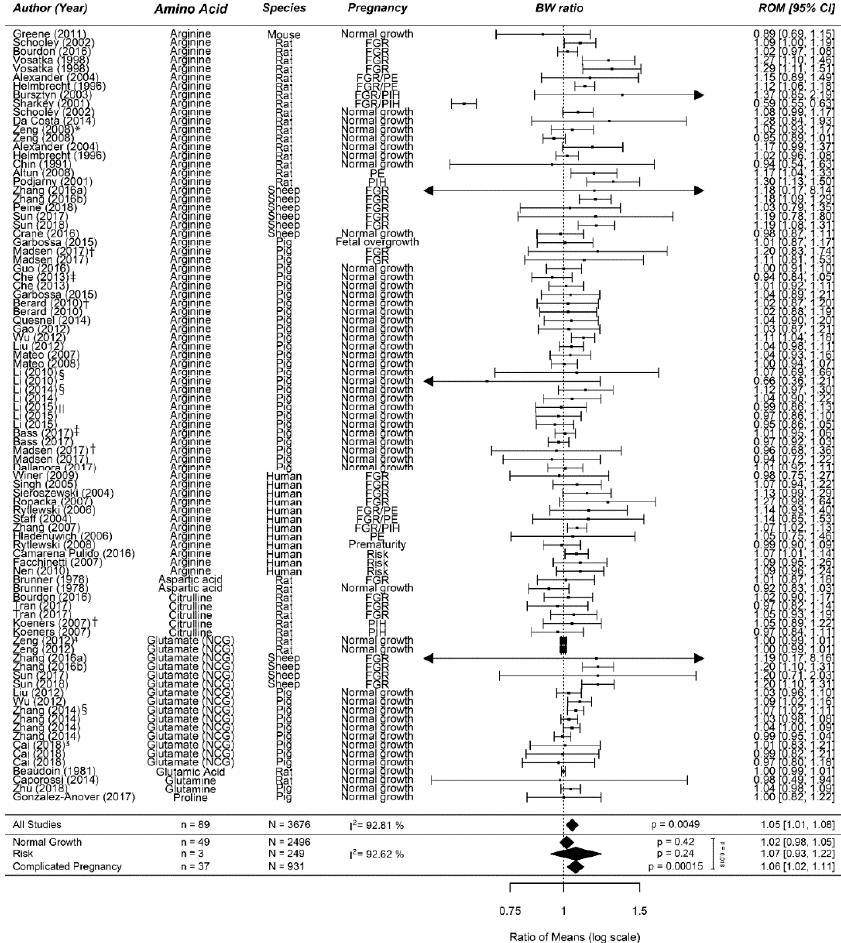
Figure 1. Meta-analysis on prenatal supplementation of amino acids from the arginine family on fetal / birth weight (BW): While there was no e ff ect of prenatal supplementation of amino acids from the arginine family in normal-growth pregnancies, it increased the birth weight ratio in a risk population and in complicated pregnancies. The data is ordered within each amino acid from smallest to largest animal. Data represent pooled estimates expressed as a ratio of means (ROM) with a 95% confidence interval (CI) using a random e ff ect model. Residual I 2 is shown. Some studies had multiple cohorts and are distinguishable in this figure by the following: * supplementation during full pregnancy in this upper line compared to partial in the next line; † this upper line is female o ff spring compared to the next line which is male o ff spring; ‡ in this upper line, the supplementation period was shorter compared to the next line(s); § in this upper line, the daily dose is lower compared to the next line(s); || in this upper line, primigravid animals were used compared to the next two lines of multigravida animals; and in the last two lines, the dose di ff ered with the first one being the highest dose. FGR, fetal growth restriction; I 2 , heterogeneity; NCG, N -(Carbamyl) glutamate; PE, preeclampsia; PIH, pregnancy induced hypertension.